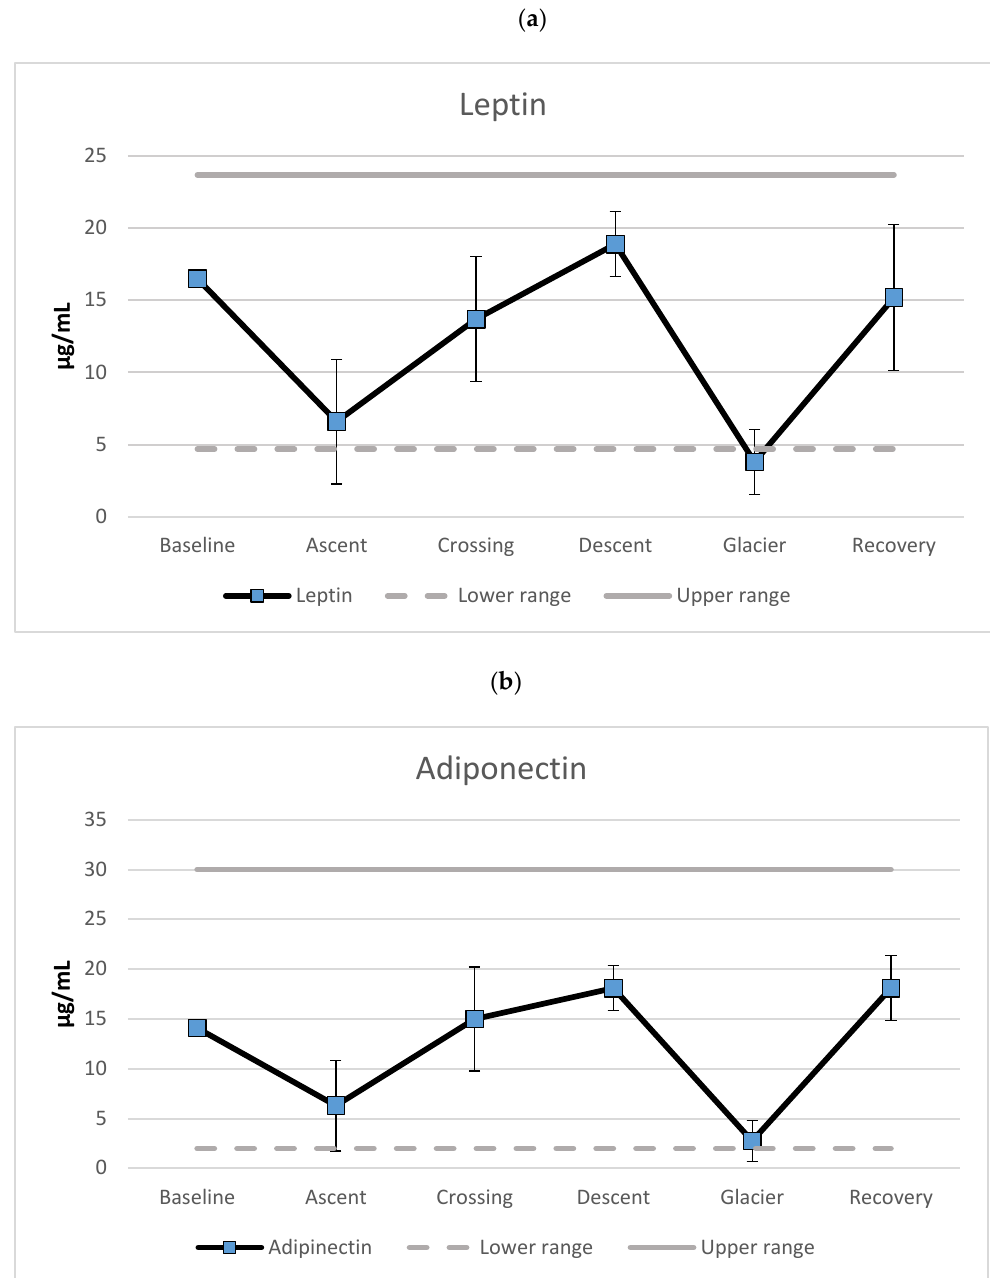
Figure 1. Mean levels of ( a ) leptin and ( b ) adiponectin (µg/mL) separated for the different phases of the expedition. Error bars represent standard deviations.